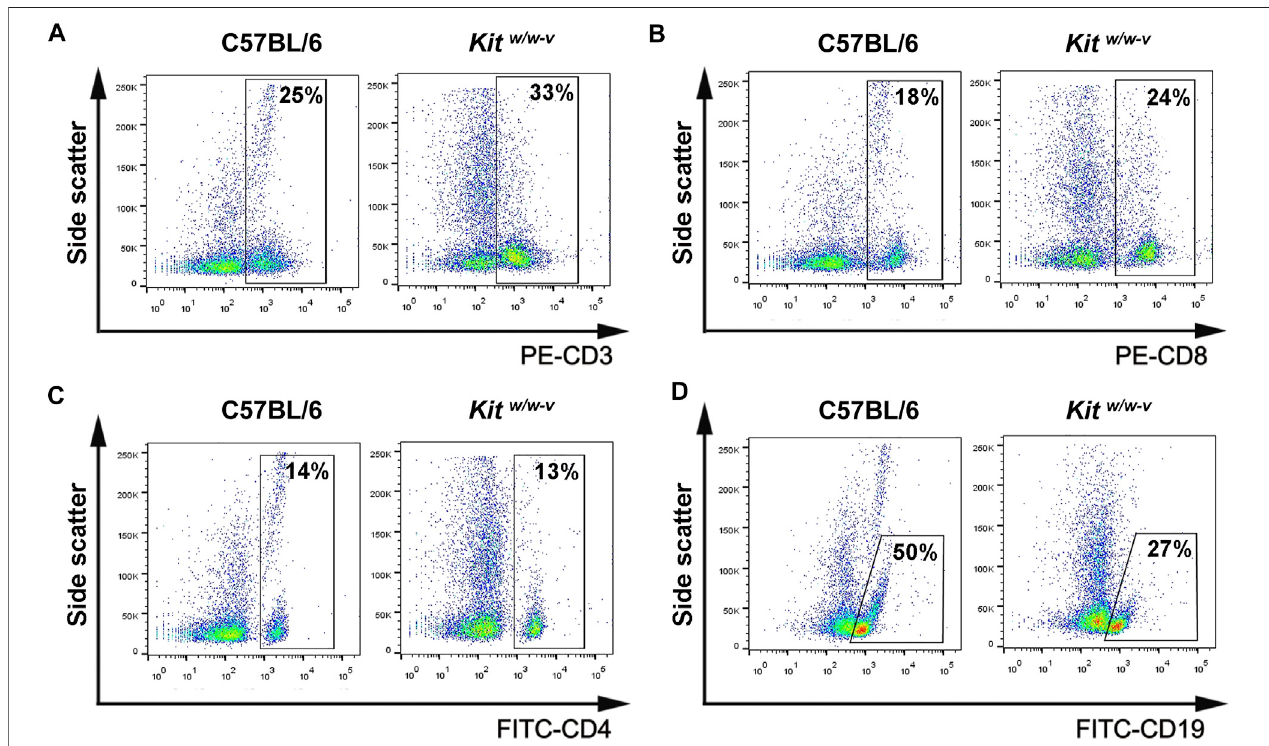
FIGURE2| Kit w/w-v micedisplayedsimilarperipherallymphocytecomposition,comparedtoC57BL/6Jimmune-competentwildtypemice. (A – D) Thepercentages ofCD3 + ,CD8 + ,andCD4 + Tlymphocytes,aswellasCD19 + Blymphocytesfromperipheralbloodfrom Kit w/w-v andC57BL/6miceweredeterminedwith fl owcytometry.